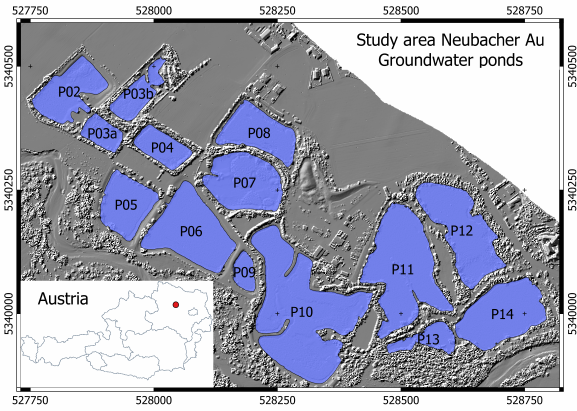
Figure 2. Topo-Bathymetric LiDAR area Neubacher Au, Pielach River, Austria with depicted ground water ponds (blue polygons), coordinate frame: ETRS89/UTM